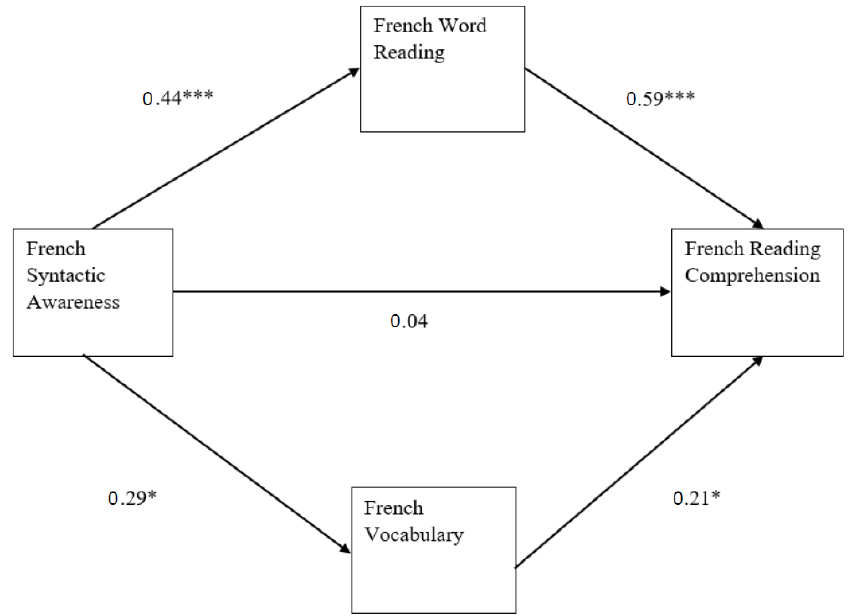
Figure 1. The French within-language model with standardized coefficients. *** p < 0.001; * p < 0.05. All coefficients are standardized.